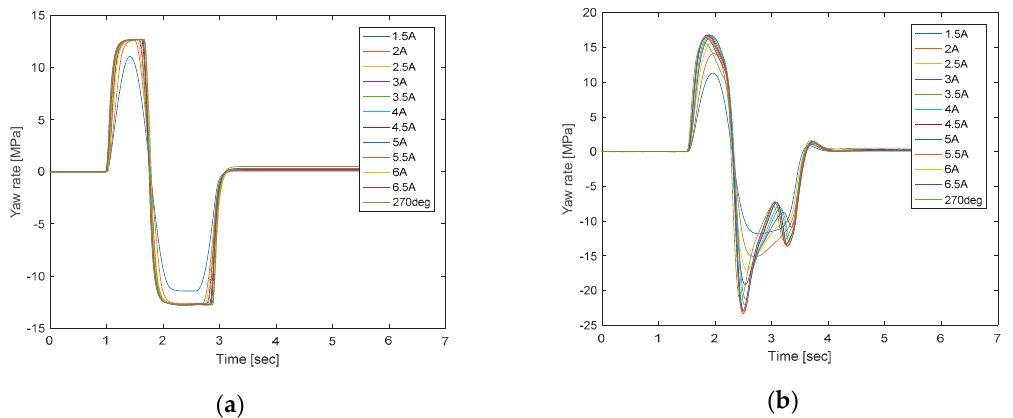
Figure 21. The yaw rate graphs of the vehicle model based on tire force observation when 𝜇 = 0.5. ( a , b ) are graphs of nominal yaw rate and actual yaw rate when the road adhesion coefficient is 0.5, using the vehicle model based on tire force observation.